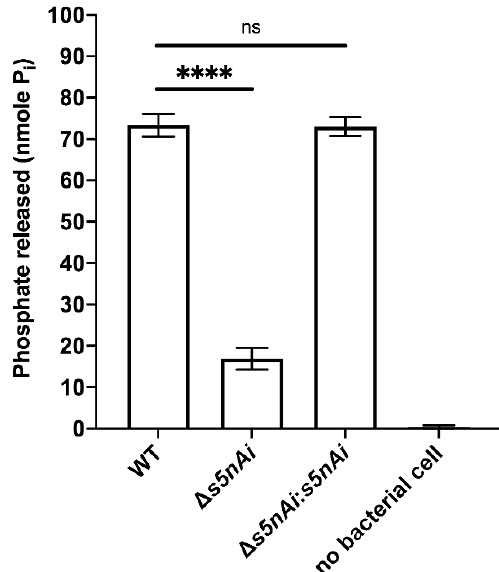
Figure 3. Nucleotidase activity of S. iniae strains. WT, ∆ s5nAi and ∆ s5nAi : s5nAi were incubated with 1 mM AMP as a substrate and the P i released was measured using a malachite green phosphate colorimetric assay. Error bars show the standard deviation of three experiments performed in triplicate. ****, p < 0.0001; ns, not significant (as determined by an unpaired two-tailed t -test).